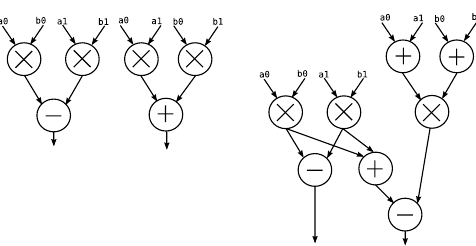
-multiplication – schoolbook (left), Karatsuba Figure 12: F p 2